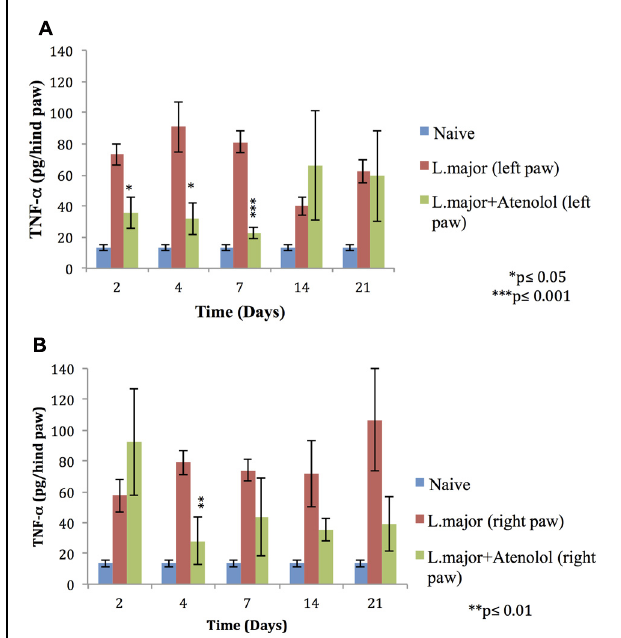
FIGURE 6 | Effect of the daily i.p. injection of atenolol on the level of TNF- α in the paws of mice infected with high dose (4 × 10 6 promastigotes/50 μ l nutrient broth medium/left hind paw) of L. major : (A) left (infected) paws (B) right (non-infected) paws. Mice were injected with 2.0 mg/kg of atenolol (i.p.) for 7 consecutive days and the levels of TNF- α were assessed at days 2, 4, 7, 14, and 21 post-infection. Each result is the mean of 5 mice ± SEM and the degree of significance was calculated with reference to atenolol non-treated infected